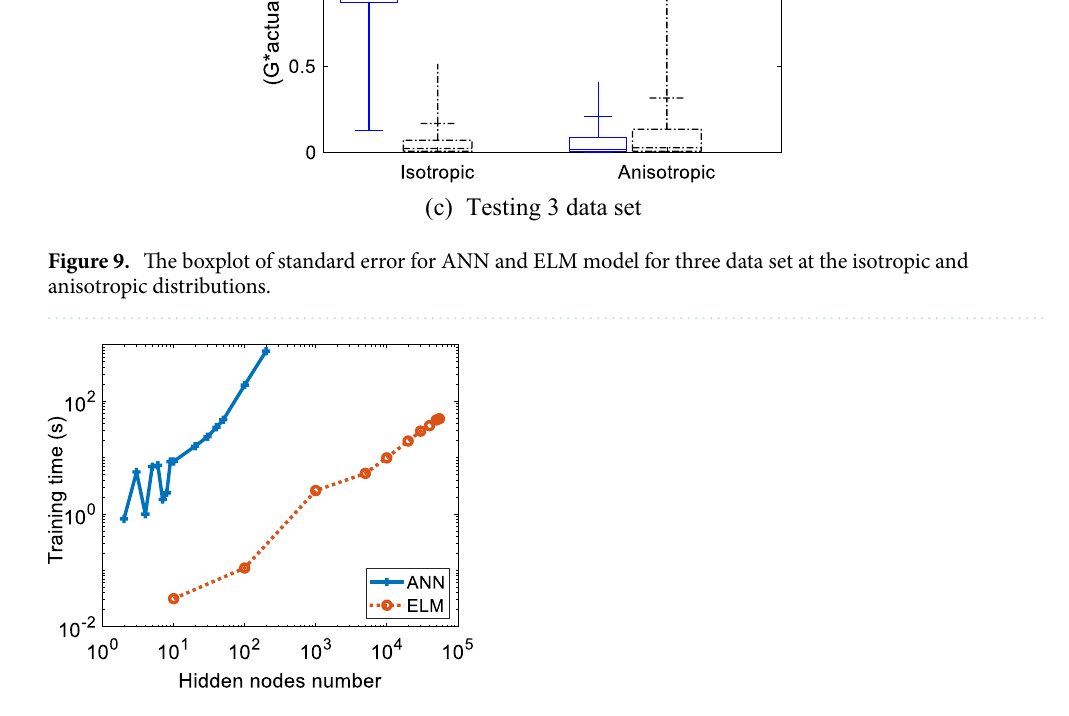
Figure 10. The training time for applied hidden nodes of ANN and ELM